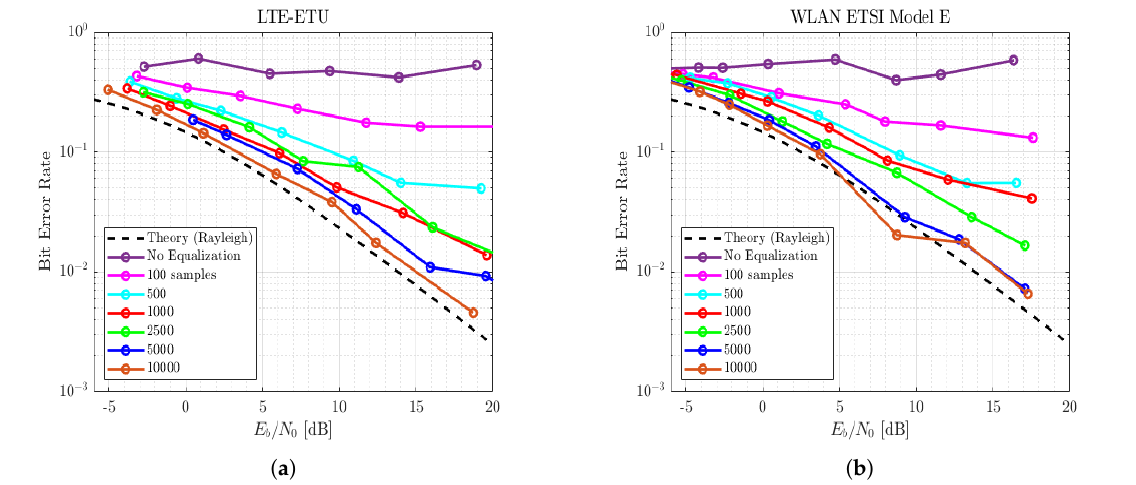
Figure 11. Channel equalization results for various known BPSK beacon preambles for NLoS Rayleigh distributed channel models: ( a ) LTE-ETU and ( b ) WLAN ETSI Model